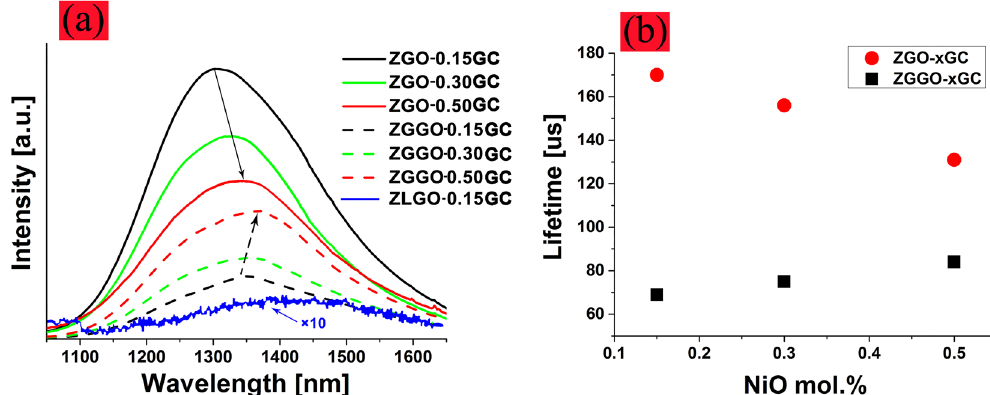
Figure 3. ( a ) Emission spectra of ZnGa 2 O 4 : Ni 2 + (ZGO- x GC, solid lines) and Zn 1 + x Ga 2 − 2 x Ge x O 4 : Ni 2 + (ZGGO- x GC, dashed lines) nanocrystals embedded GCs with varying NiO ( x , mol. %). Also shown is that of Zn 2 GeO 4 / Li 2 Ge 4 O 9 : Ni 2 + embedded GCs (ZLGO-0.15GC, dotted line) with the intensity multiplied by an order of ten for the purpose of clarity; ( b ) Lifetime of the NIR emission of the ZGO and ZGGO GCs as a function of